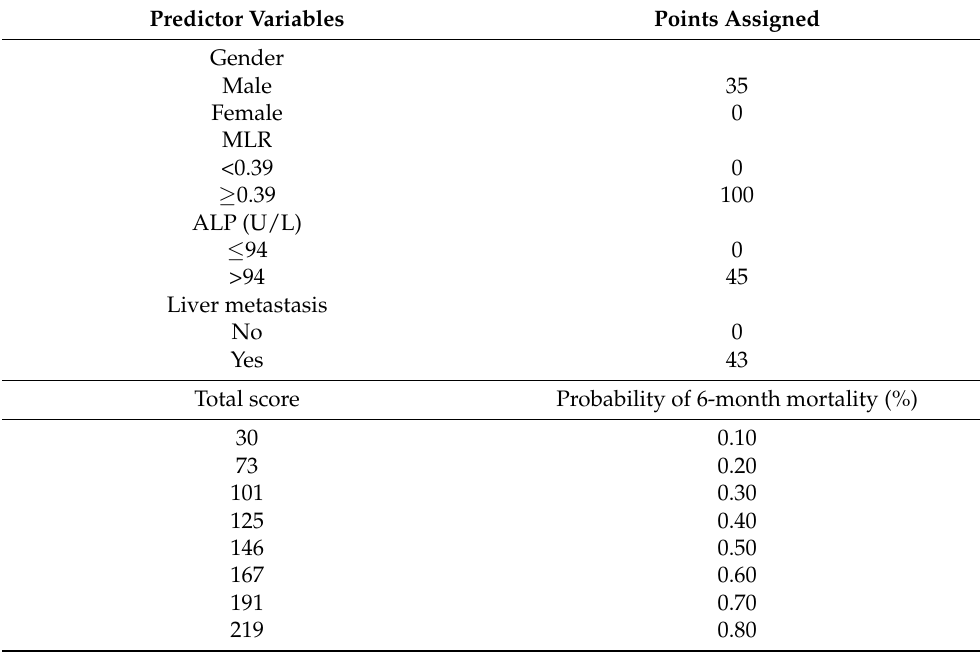
mortality associated with different total point values.